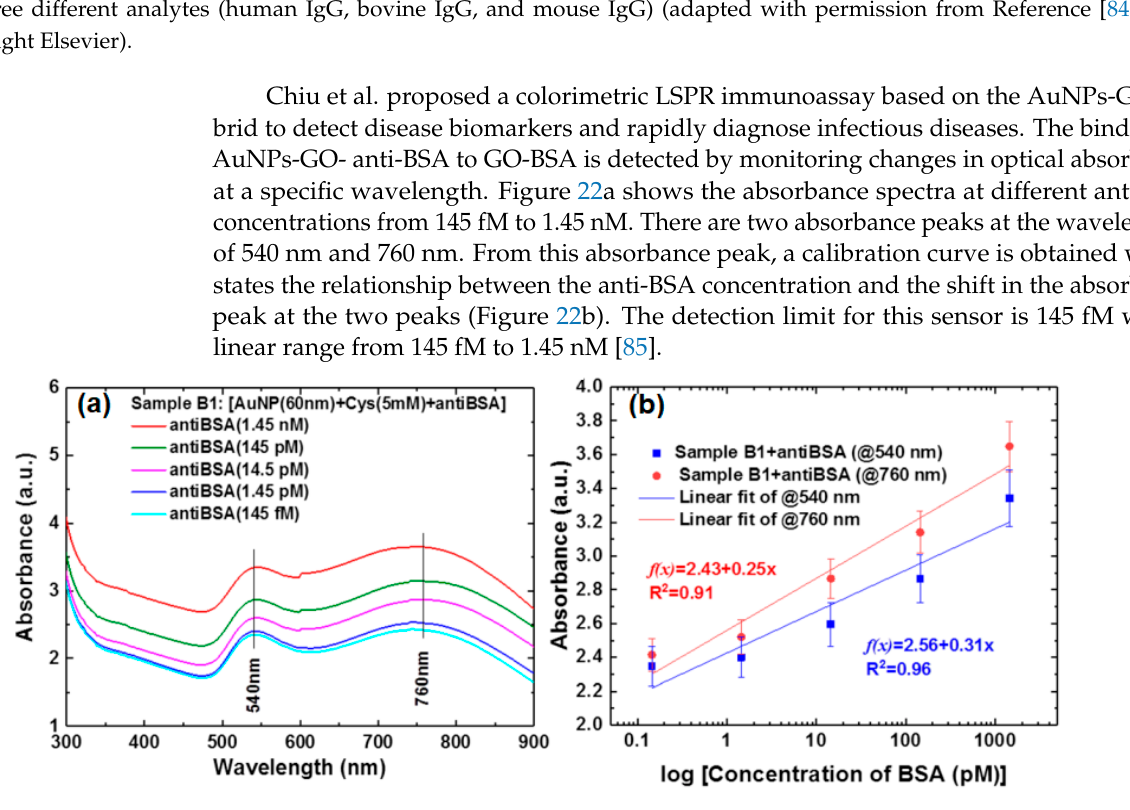
Figure 22. ( a ) The relationship between optical absorbance and wavelength at different anti BSA concentrations (145 fM– 1.45 nM). ( b ) Calibration curves obtained from shifts in absorbance peaks (A and B) due to detection of anti-BSA with different concentrations (adapted with permission from Reference [85], copyright Springer Nature).